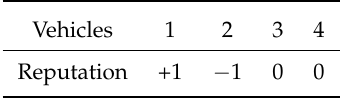
Table 2. Reputation for malicious accusation.